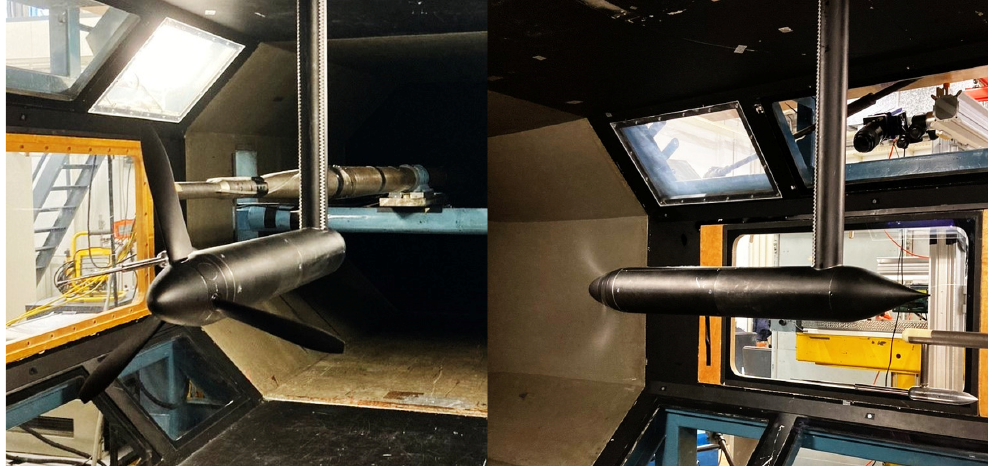
Figure 2. Photos of the experimental setup employed for the measurement campaign at Delft University of Technology’s Low-Turbulence Tunnel.